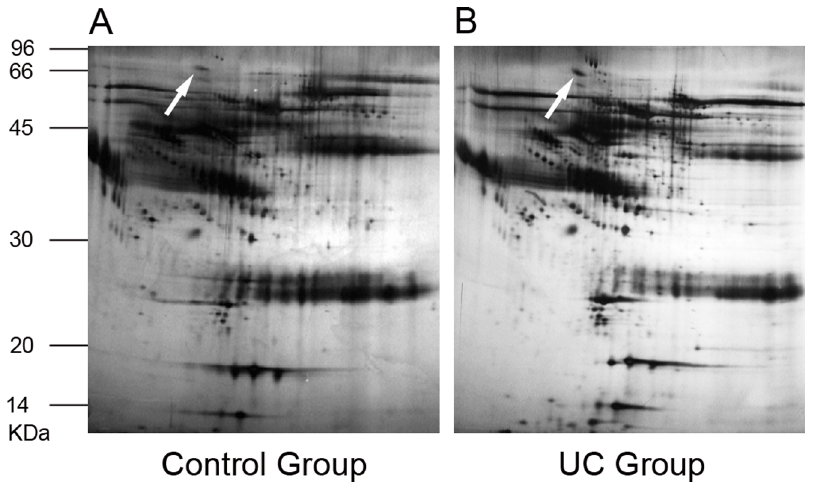
Figure 1. Total proteins from serum of normal control subjects and UC patients were analyzed by 2-DE. The proteins were separated by IEF (pH 3–10) and 10% SDS-PAGE and subsequently processed with silver staining. The spot marked with white arrow represented HSF2. A : Total proteins from serum of normal controls that were analyzed by 2-DE. B : Total proteins from serum of UC patients that were analyzed by 2-DE.